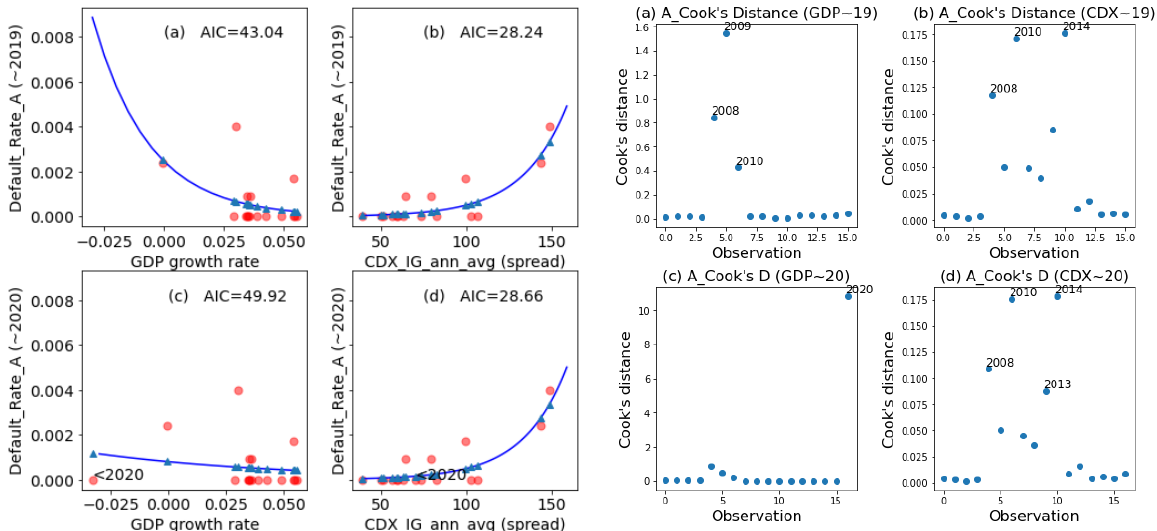
Figure 6. Fitted logistic regression models ( left panel ) and Cook’s distances ( right panel ) of default rate in relation to ( a ) GDP in 2004–2019 data; ( b ) CDX.NA.IG in 2004–2019 data; ( c ) GDP in 2004–2020 data; and ( d ) CDX.NA.IG in 2004–2020 data (spread) for A class ratings.